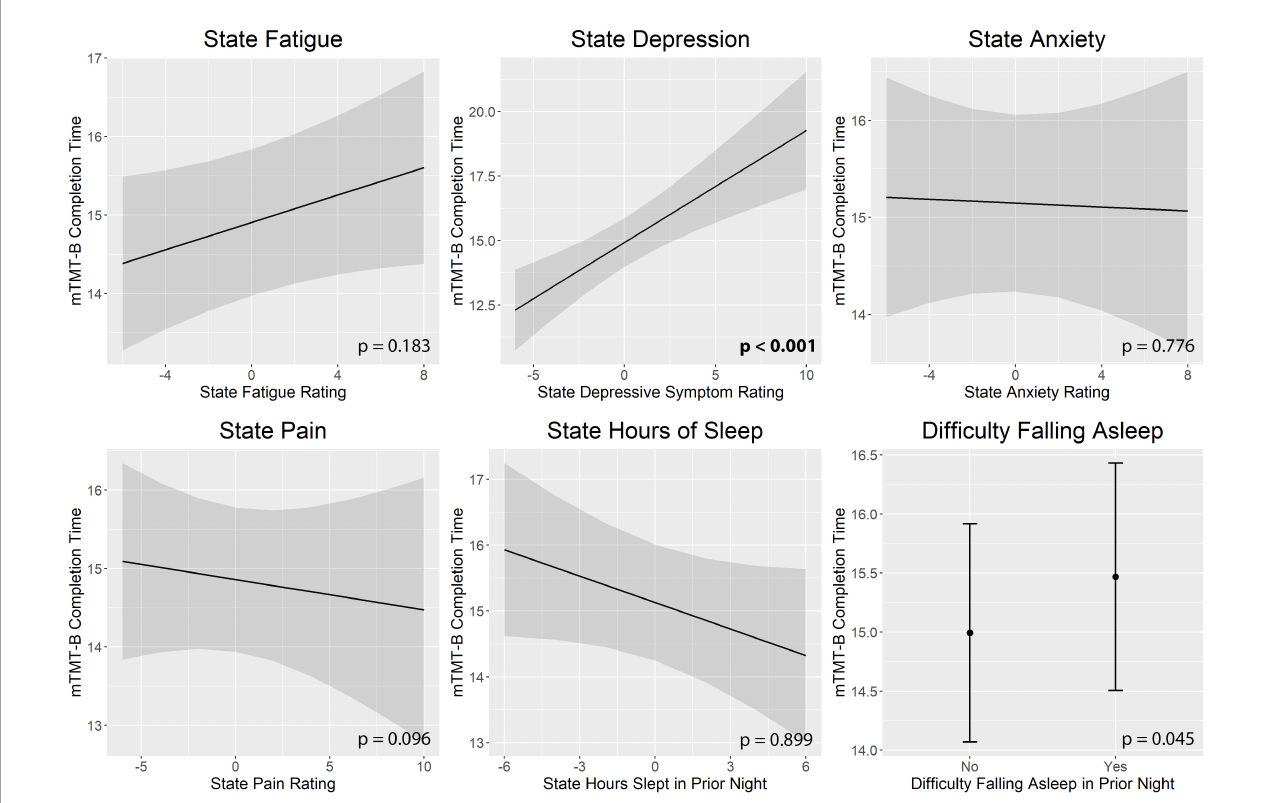
FIGURE3 Real-time associations between non-cognitive symptom ratings and mTMT-B performance. Among all non-cognitive symptom ratings, only more severe state depressive symptoms was associated with slower mTMT-B completion time. State and trait aspects of each symptom was tested together in the same model; plots show the marginal effects of the state variables. All models included subject and concatenated subject and day variable as random intercepts; and age, mean bilateral finger tapping performance, state and trait upper extremity weakness rating, and measurement number as fixed effects. mTMT-B, mobile Trail-Making Test part B. Error bands represent 95% confidence